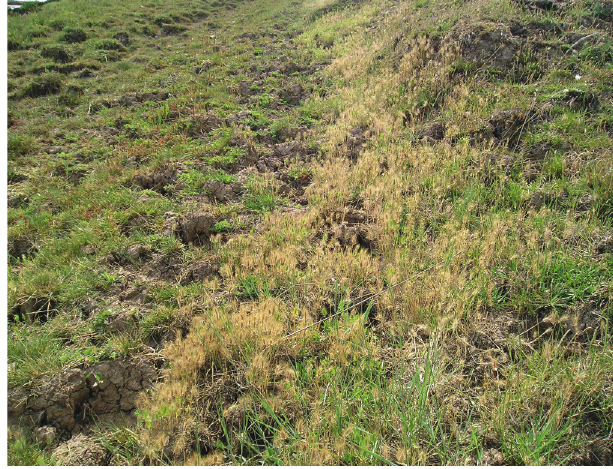
Fig. 5. Post-grazing cattle damage; credit T. Gardiner.